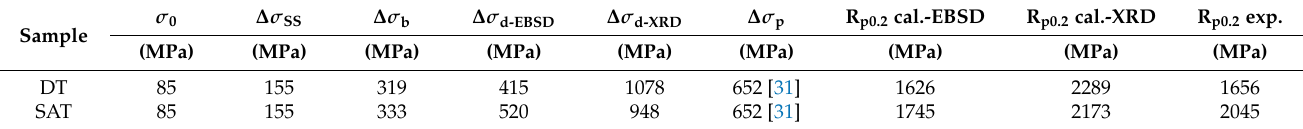
Table 4. Summary of individual strengthening contributions: σ 0 —lattice friction stress; ∆ σ ss —solid solution strengthening; ∆ σ g —grain boundary strengthening; ∆ σ d-EBSD —dislocation strengthening cal- culated from EBSD analysis; ∆ σ d-XRD —dislocation strengthening calculated from XRD analysis; and ∆ σ p —precipitation strengthening from [38]. R p0.2 cal.—calculated yield strength; R p0.2 exp.—experimental yield strength